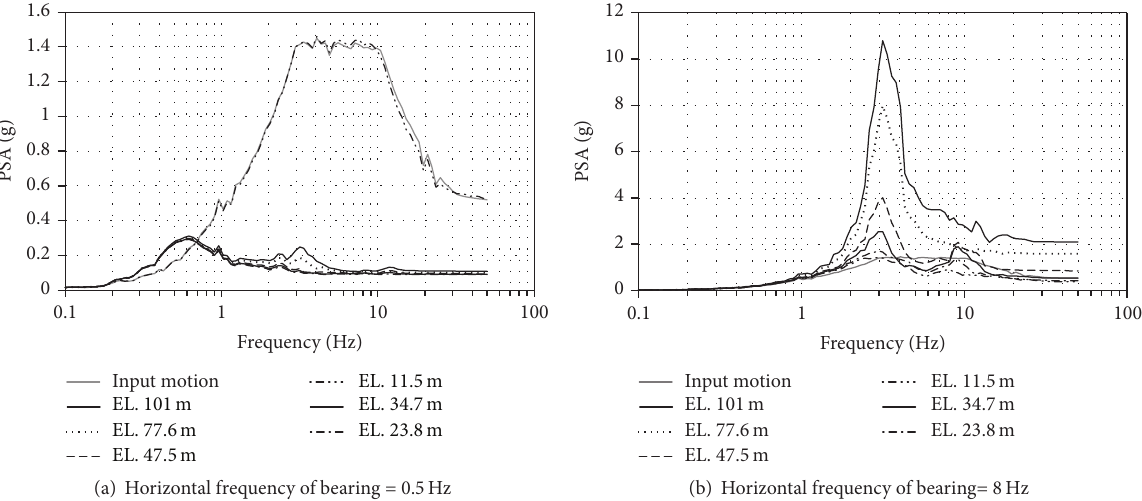
Figure 16: PSA comparison at different elevation.